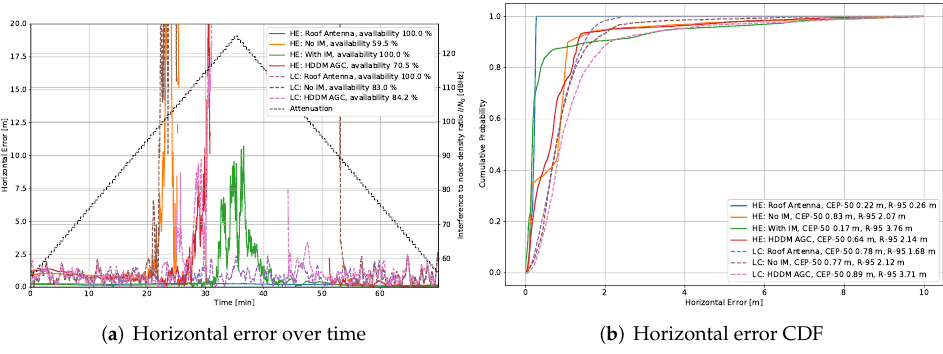
Figure A22. Interference #4: Fast frequency hopper with a dwell time of 1us and a frequency range of 35MHz.